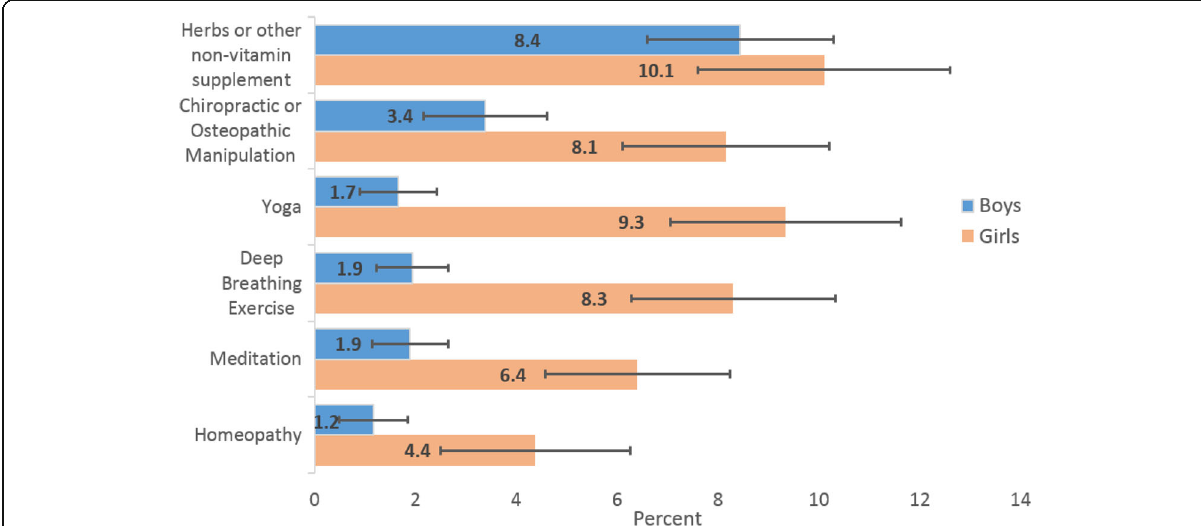
Fig. 3 Gender difference in CAM use among children with mental health